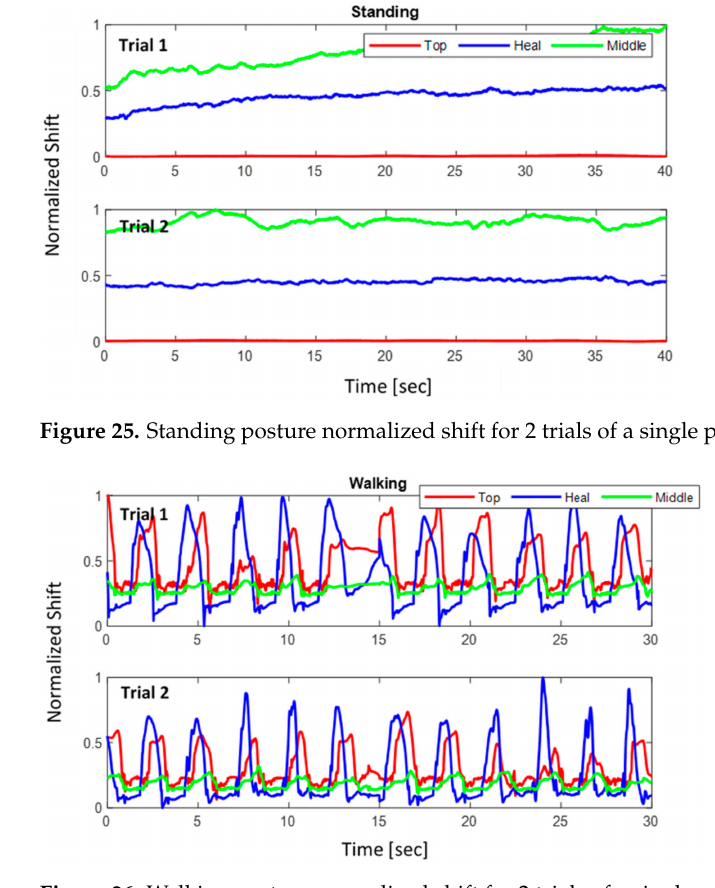
Figure 26. Walking posture normalized shift for 2 trials of a single participant.